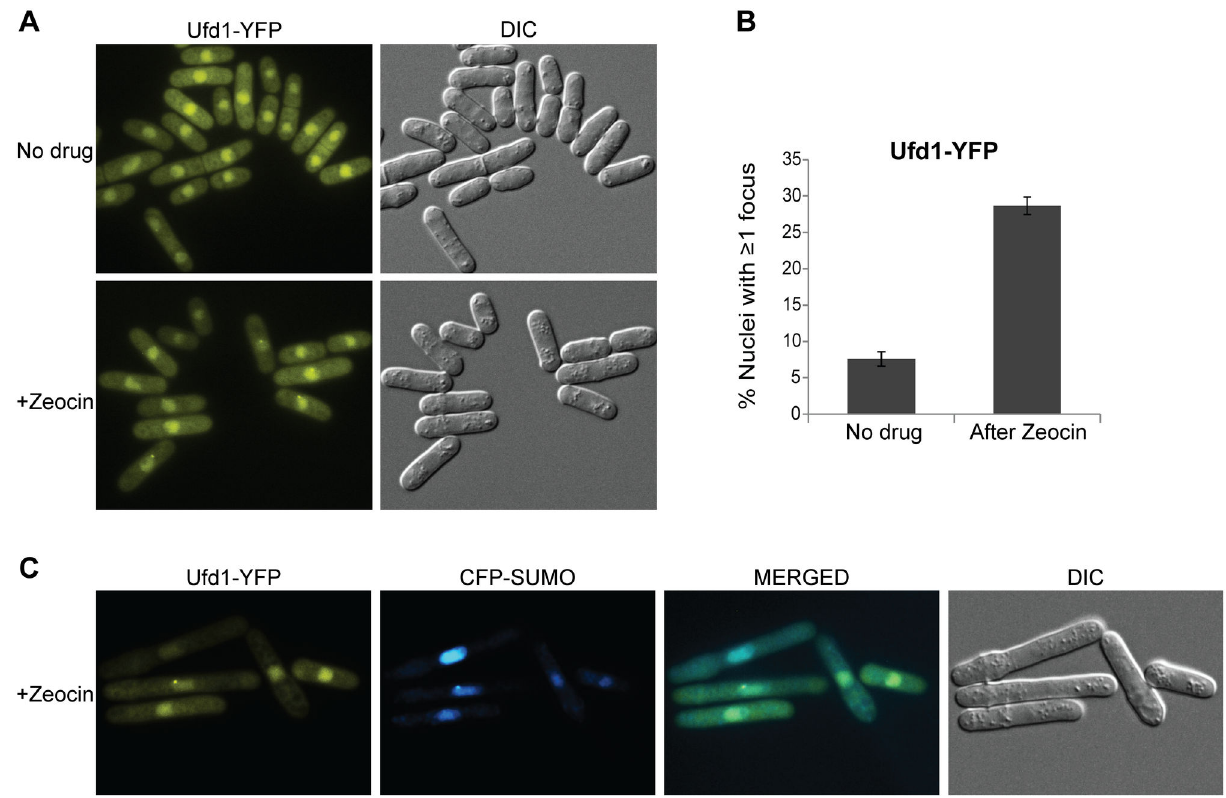
Figure 3. Ufd1 forms foci upon DNA damage which colocalize with CFP-SUMO. (A) Fluorescence imaging of cells expressing Ufd1-YFP propagated in the presence or absence of Zeocin (350 µg/ml for 3 1/2 hrs). (B) Bars represent the percentage of cells with at least one Ufd1-YFP focus before and after Zeocin treatment averaged from three independent experiments. (C) Colocalization of Ufd1-YFP with CFP-SUMO after Zeocin